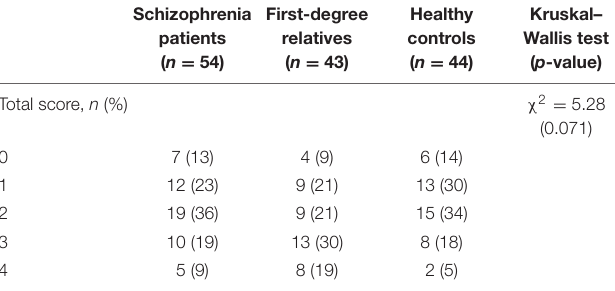
TABLE 5 | Descriptive and comparative analysis between groups on the CIT total